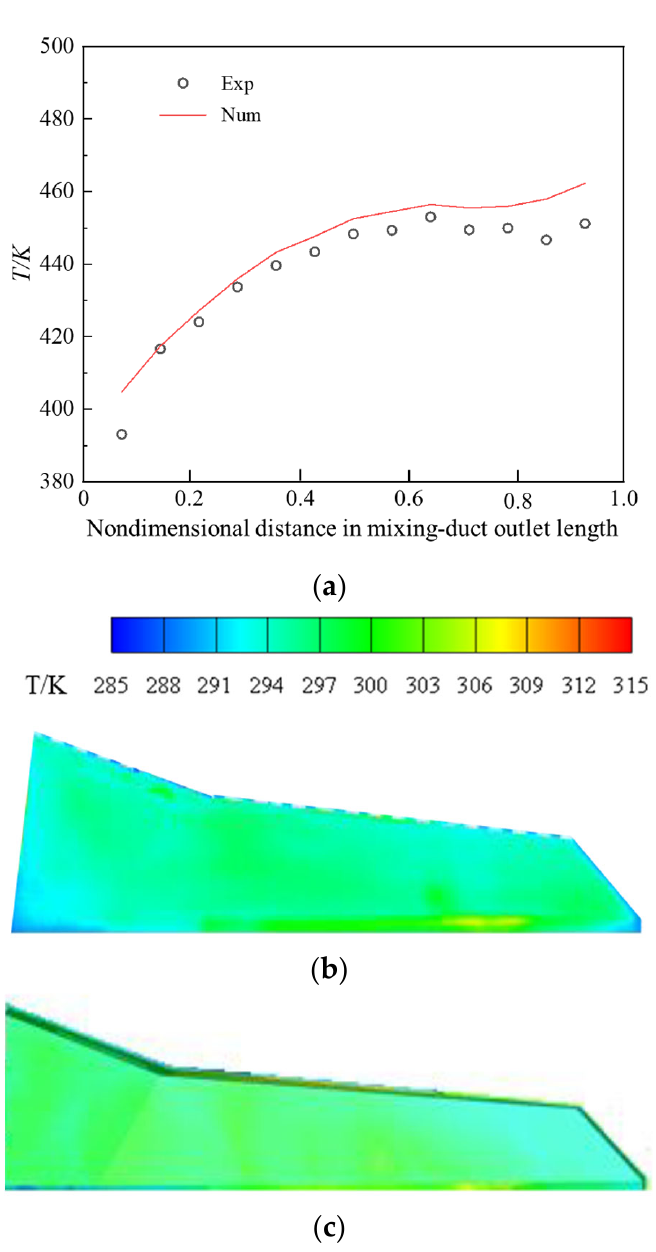
Figure 5. Validation of temperature distribution on a test model. ( a ) Comparison of exhaust temperature distributions. ( b ) Thermal image from the test. ( c ) Thermal image from numerical simulation.